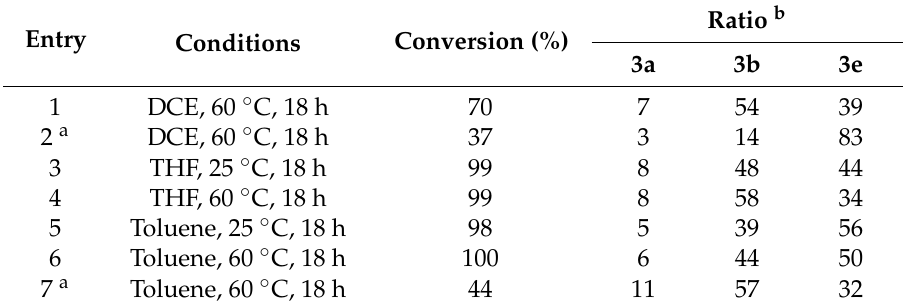
Table 3. Solvent screen for the hydroboration of 2 using PinBH and 5–10 mol % Rh(COD)(DPPB)BF 4